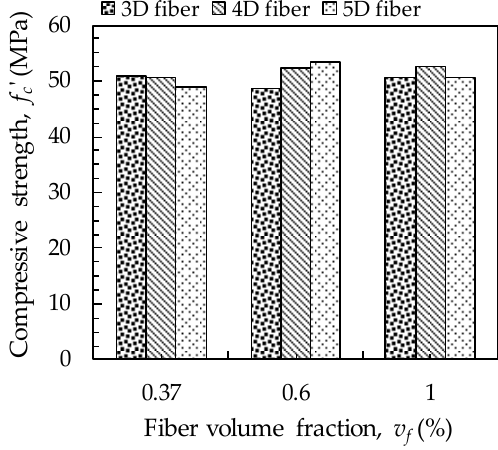
Figure 4. Summary of compressive strengths.